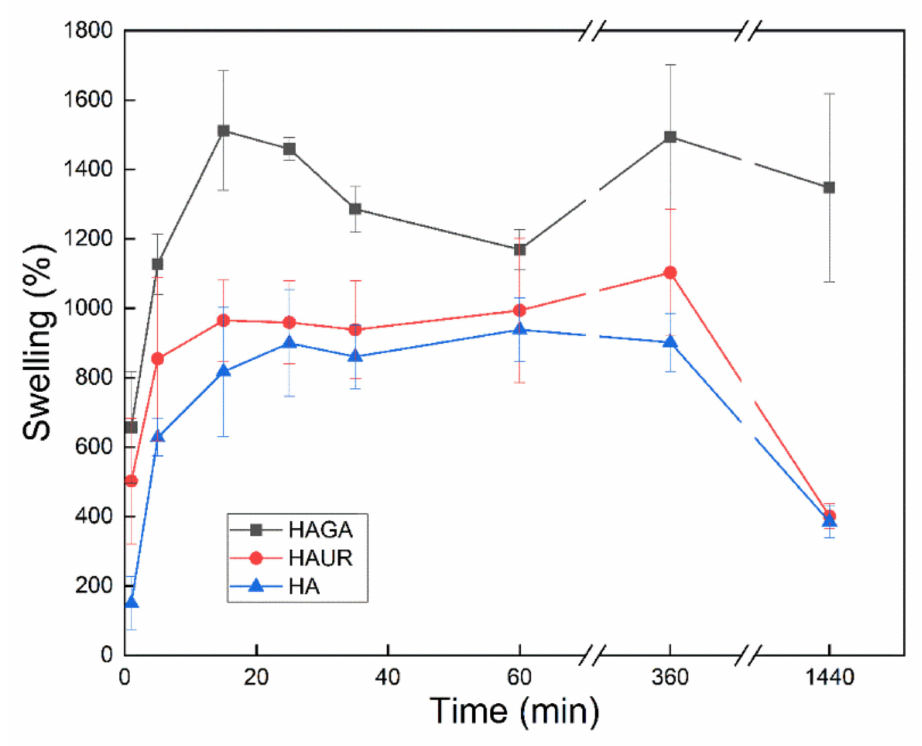
Figure 8. Swelling of microparticles formed from native (HA) and crosslinked (HAGA and HAUR) HA. Bars represent standard error of the